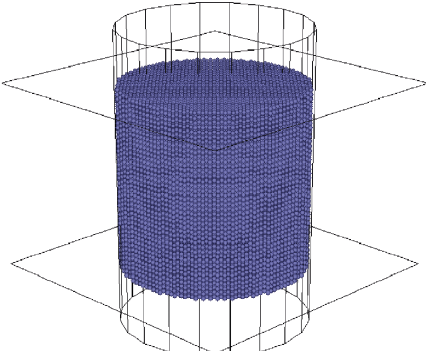
Figure 5: Regular arrangement